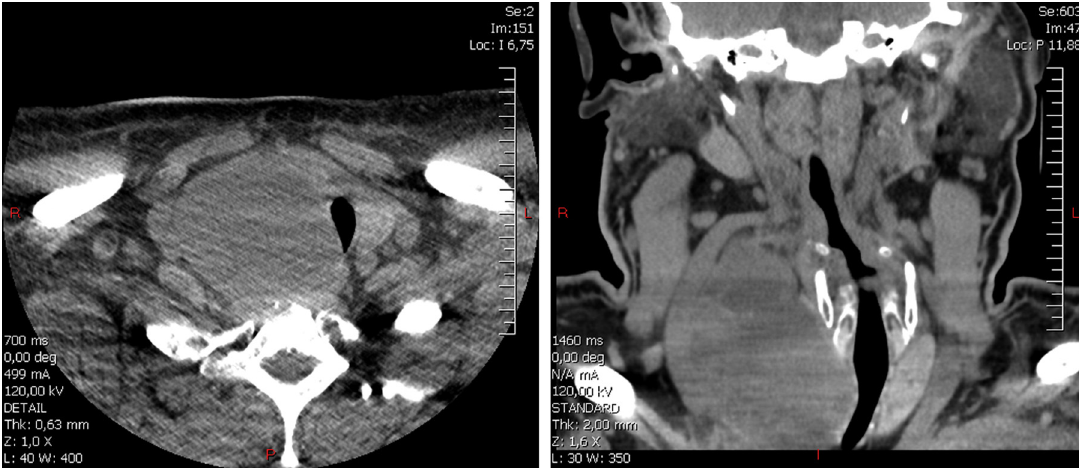
CT-scan of the thyroid mass. Due to the patient’s chronic kidney failure, intravenous contrast could not be used. Note the important tracheal compression on the transverse plane (left) and important tracheal and vessel deviation on the coronal plane (right). The mass measured 90 mm × 54 mm × 68